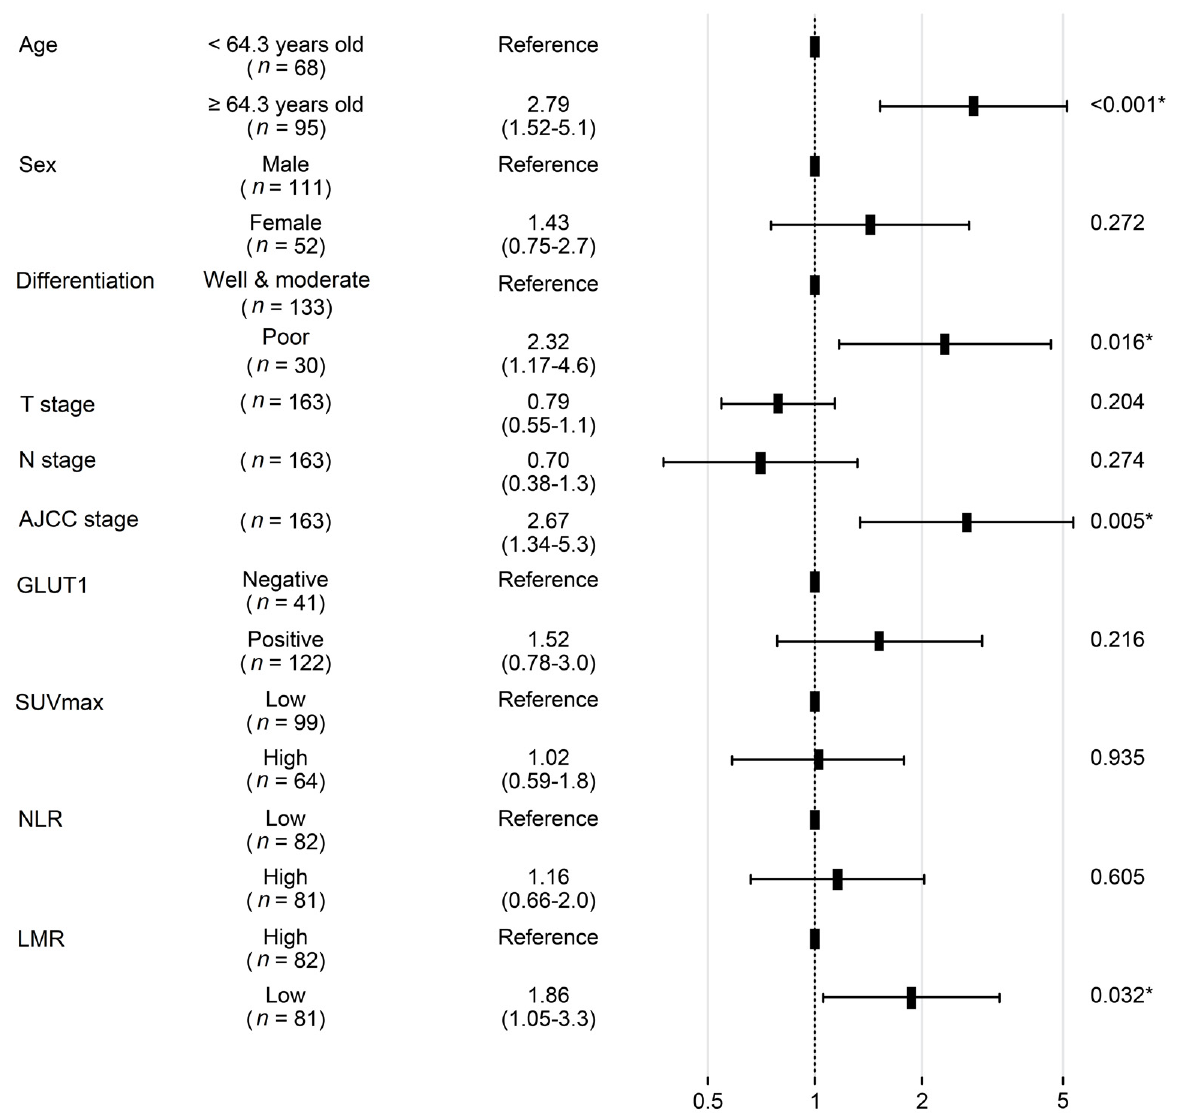
Table 3. Univariate and multivariate Cox regression analysis for overall survival in 137 Stage I, II and III non ‐ small cell lung cancer patients.